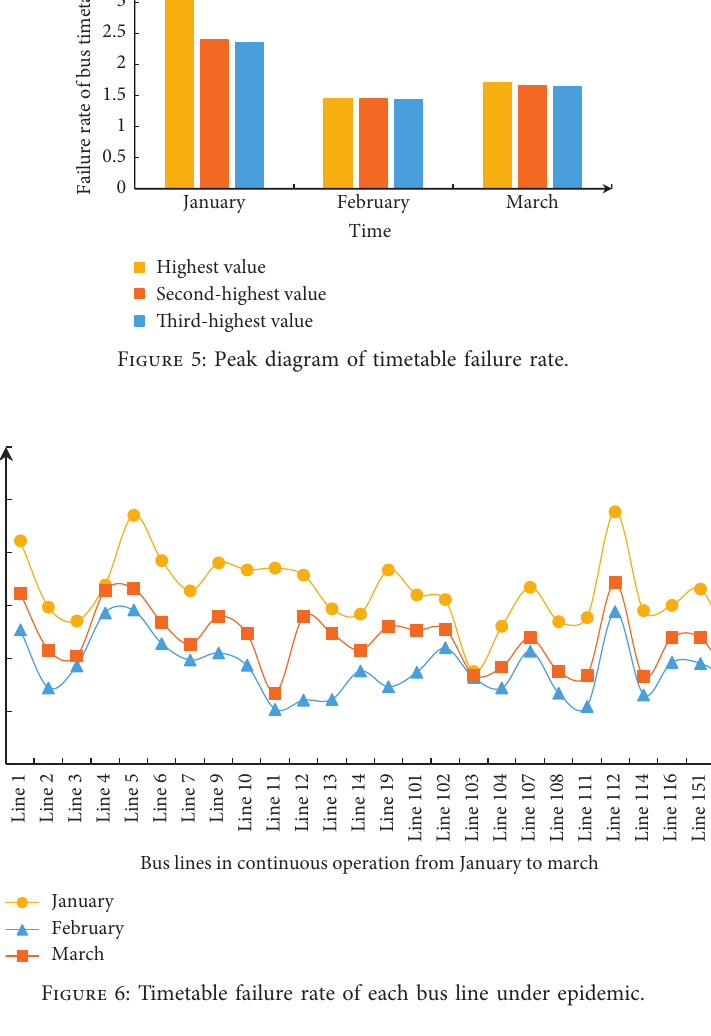
Figure 6: Timetable failure rate of each bus line under